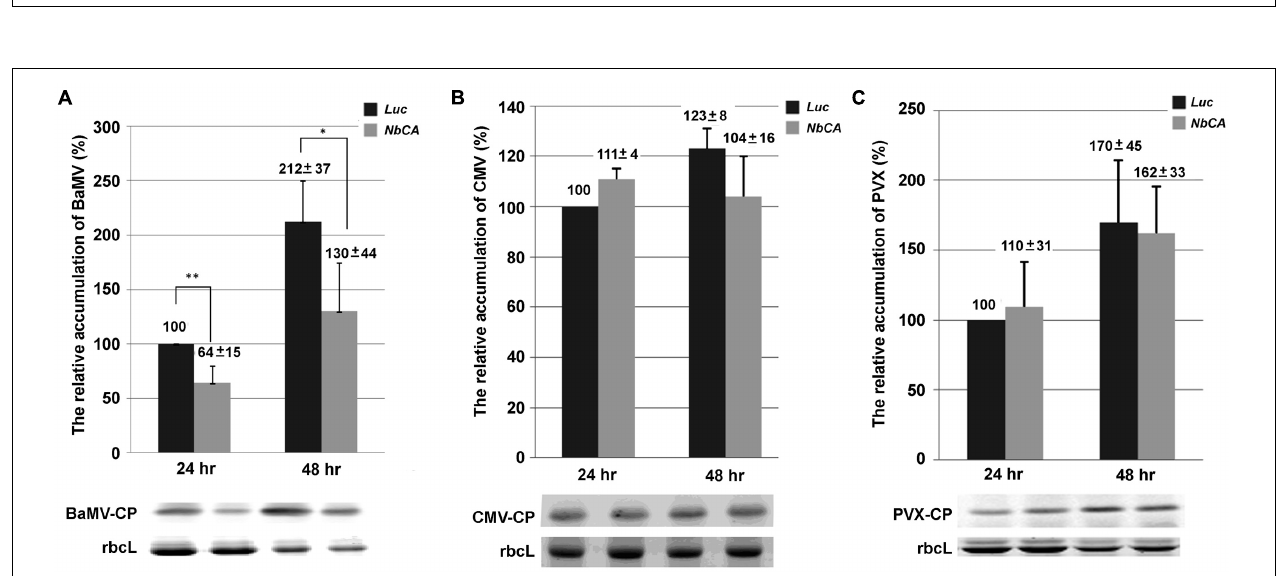
FIGURE 2 | The relative accumulation of viral coat protein in NbCA -knockdown protoplasts. Western blot analysis of the accumulation of BaMV (A) , Cucumber mosaic virus (CMV) (B) , and Potato virus X (PVX) (C) coat protein extracted from NbCA - and Luc -knockdown protoplasts at 24 and 48 h post-inoculation (hpi). Protoplasts were isolated from NbCA - and Luc -knockdown N. benthamiana plants and inoculated with 1.5 µ g BaMV, CMV, or PVX viral RNA. The accumulation of viral coat protein detected from Luc -knockdown protoplasts at 24 hpi was set to 100%. The numbers are the mean levels of coat protein with the standard error obtained from three independent experiments. Luc , luciferase-knockdown protoplasts; NbCA , NbCA -knockdown plants; CP, coat protein; rbcL, Rubisco large subunit used as a loading control; ∗ p < 0.05, ∗∗ p < 0.01 by Student’s t -test.